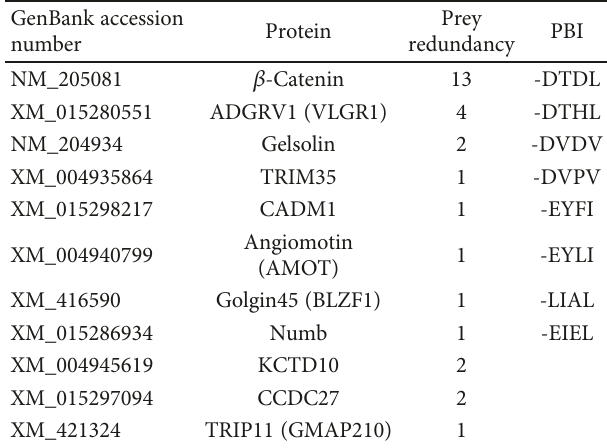
Table 1: Potential PDZD7-binding partners identi fi ed from yeast two-hybrid screening. Fragment containing the fi rst two PDZ domains of PDZD7 was used as bait to screen a chicken cochlear cDNA